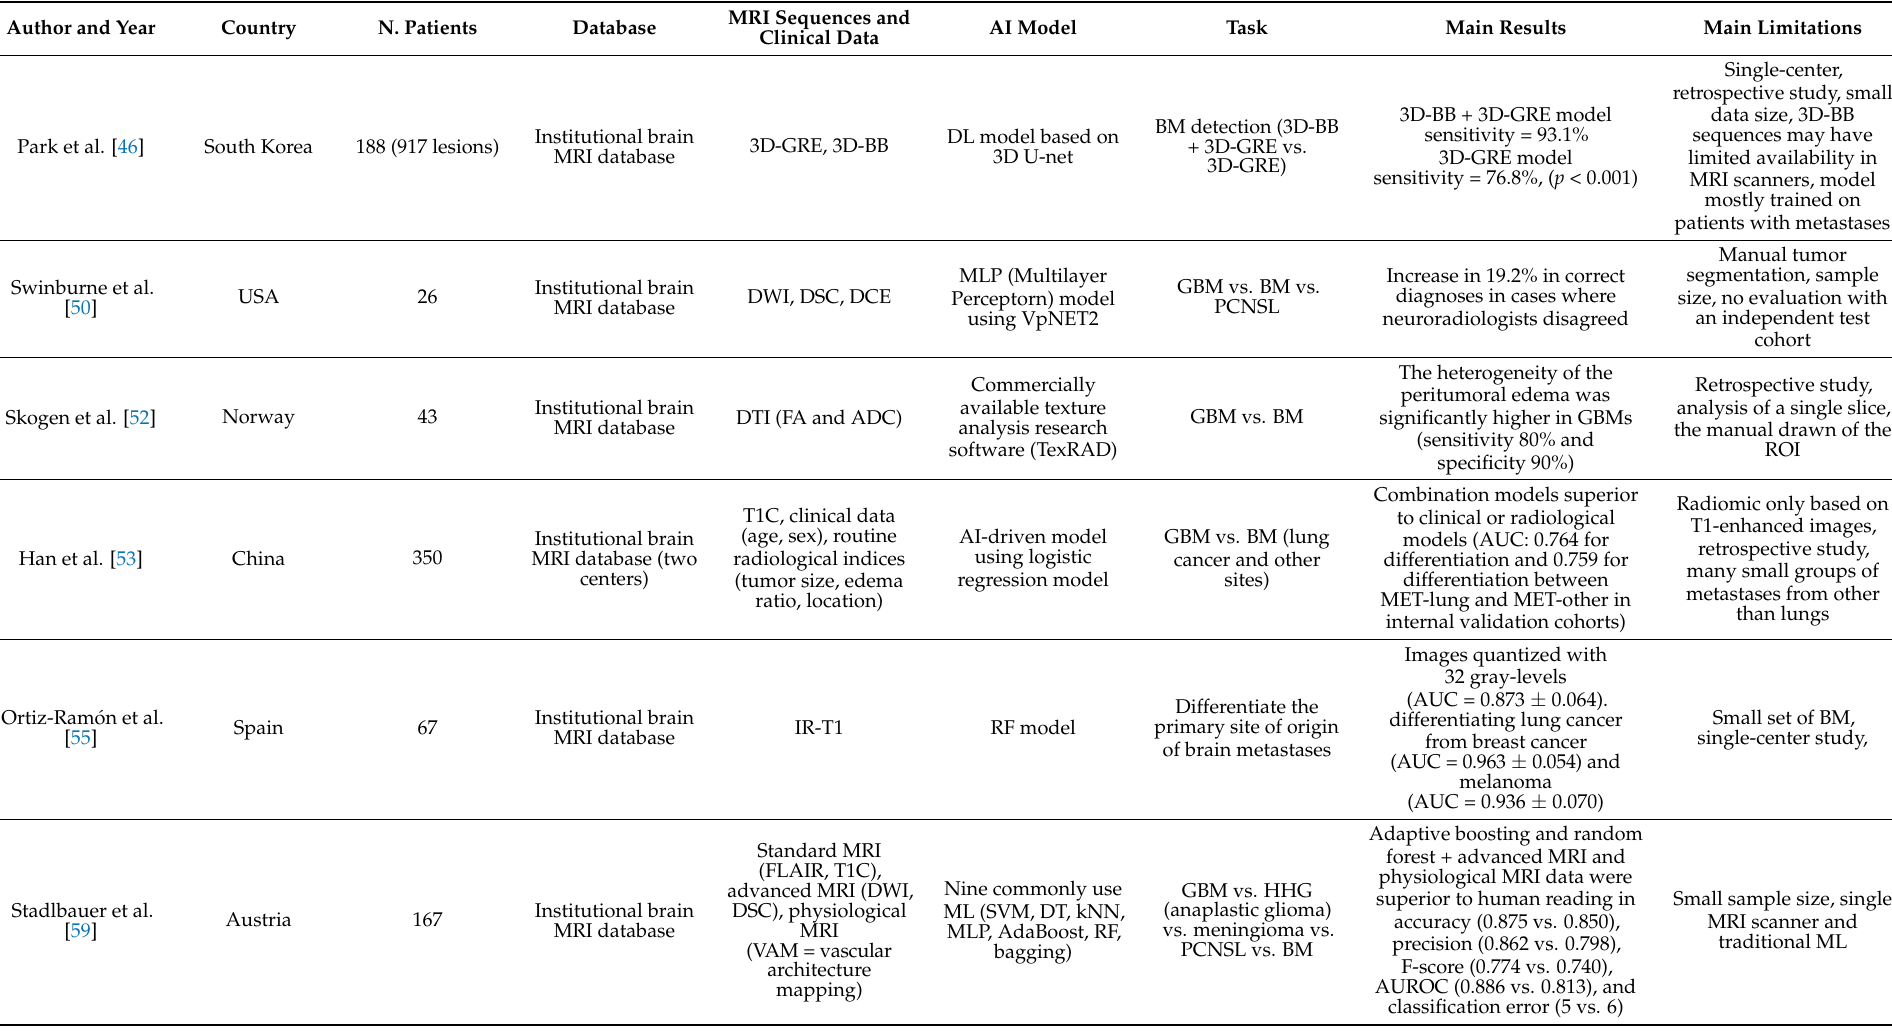
Table 1. The table reports the main characteristics and findings of the studies focused on lesion detection and the differential diagnosis of brain